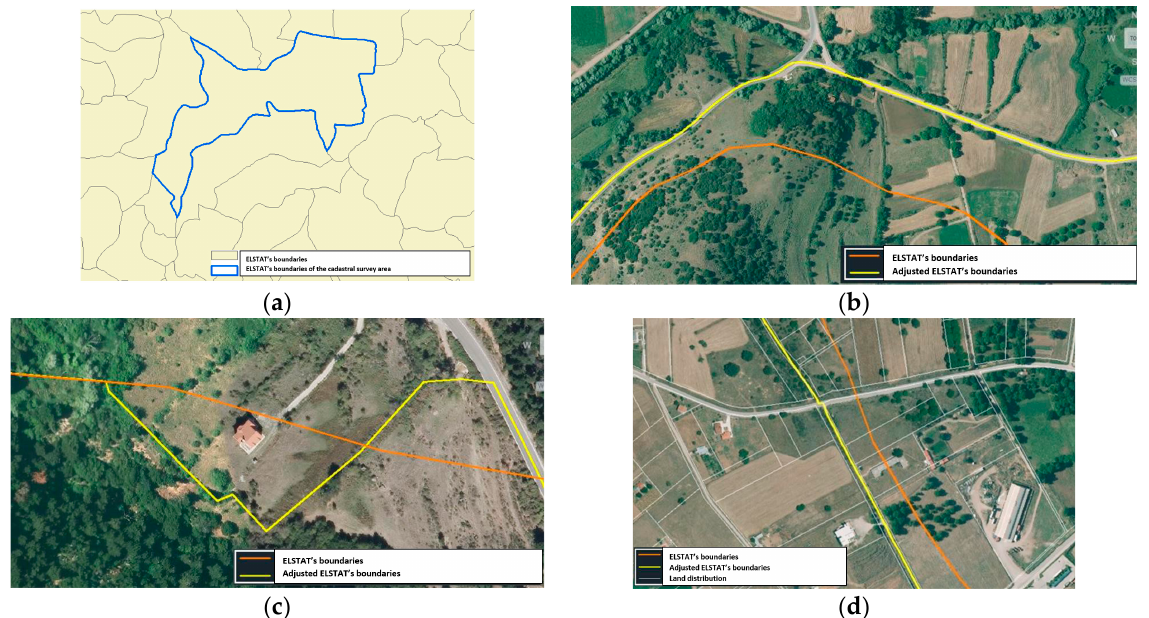
Figure 2. ( a ). ELSTAT’s boundaries of the cadastral survey area. Adjustment of ELSTAT with ( b ) road network ( c ) land parcel’s boundaries and ( d ) land distribution. Source: [35].